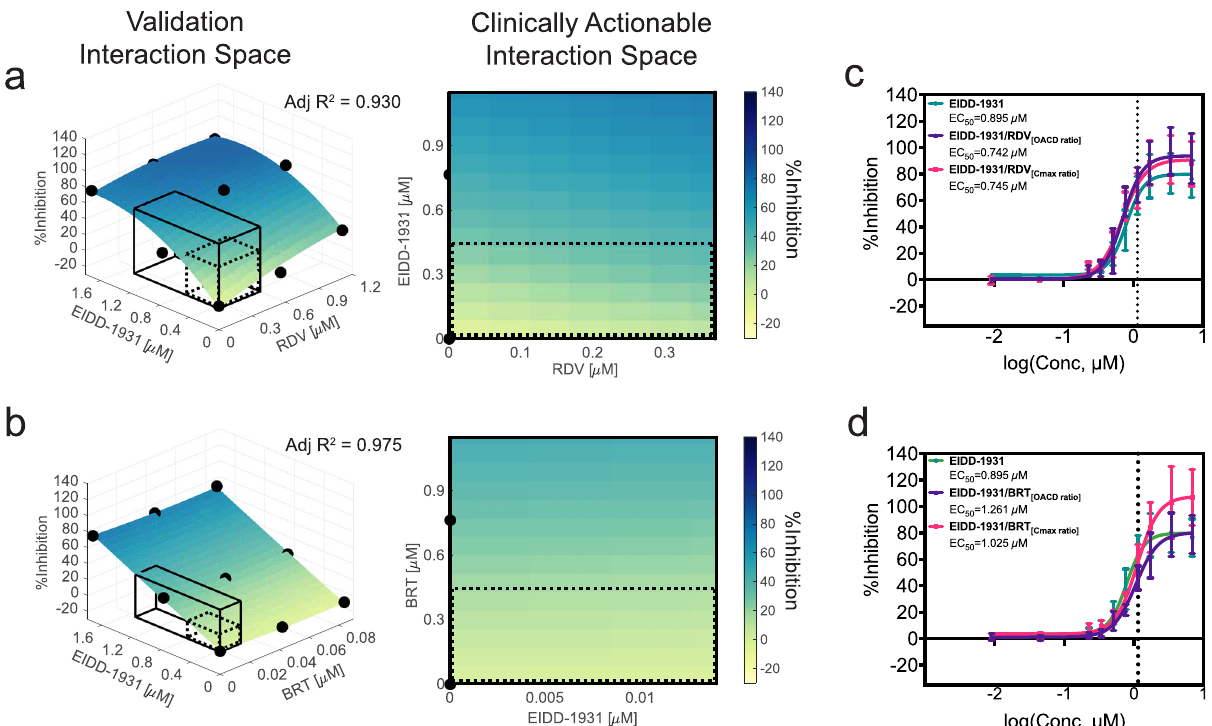
Fig. 3 Validation of EIDD-1931 drug interactions affecting %Inhibition in the propagated, original SARS-CoV-2 strain. a , b Surface plots of EIDD-1931 interactions with remdesivir (RDV) and baricitinib (BRT) in the validation interaction space, clinically actionable interaction space (black, solid line border) and the interaction space from the IDentif.AI-x analysis (black, dotted line border). The latter two are also shown as two-dimensional maps. All experiments were performed with N = 3 to 4 replicates, which were independently included in the surface construction. Black, round markers indicate an average %Inhibition of the replicates for each treatment. Adjusted R 2 (Adj R 2 ) indicates goodness of the fi t for each interaction surface. c , d Dose-response curves (D-R curves) of EIDD-1931 in monotherapy and in a combination with RDV and BRT at two concentration ratios: the ratio tested in the IDentif.AI-x experimental set (OACD ratio) and the ratio dictated by the C max values of the drugs ( C max ratio). Half maximal absolute effective concentration (EC 50 ) was derived from the D-R curves, which is the concentration that resulted in 50% Inhibition. The vertical line marks the 10% C max of EIDD-1931. Please note that the EIDD-1931-only EC 50 values (Green) were provided in both sub fi gures c and d to enable direct comparisons with both combinations (EIDD-1931/RDV and EIDD- 1931/BRT). The entire assay was completed in one experiment, realizing all data points in a single global study, and enabling comprehensive derivation of combinations and direct comparisons between monotherapies and combinations. Error bars represent propagated standard deviation (s.d.; N = 3 to 4 replicates). Of note, this propagated s.d. did not arise from the replicates ’ spread, but from plate-to-plate variation (s. d. of the controls). No statistically signi fi cant difference between the D-R curves was detected with sum of square F